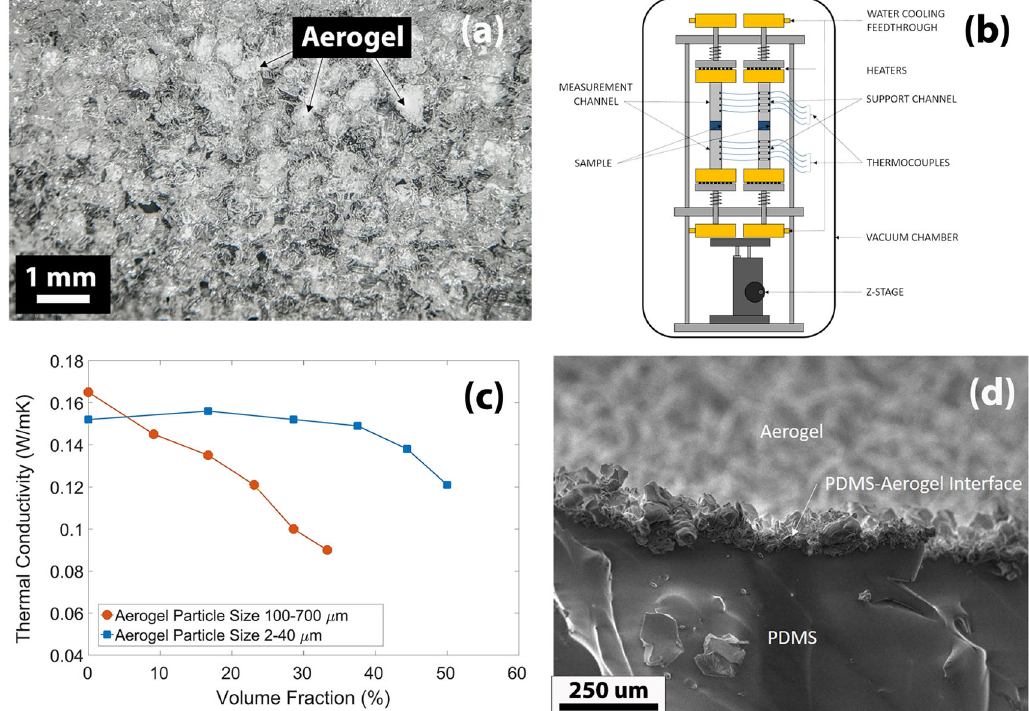
Fig. 2 Aerogel – silicone composite and its thermal conductivity. a A cross-sectional optical microscope image of the aerogel – silicone composite. b Thermal conductivity measurement system. c Thermal conductivity of the composite for two different aerogel particle sizes of 2 – 40 and 100 – 700 μ m plotted as a function of the aerogel volume fraction. d A cross-sectional scanning electron microscope image of the aerogel – silicone